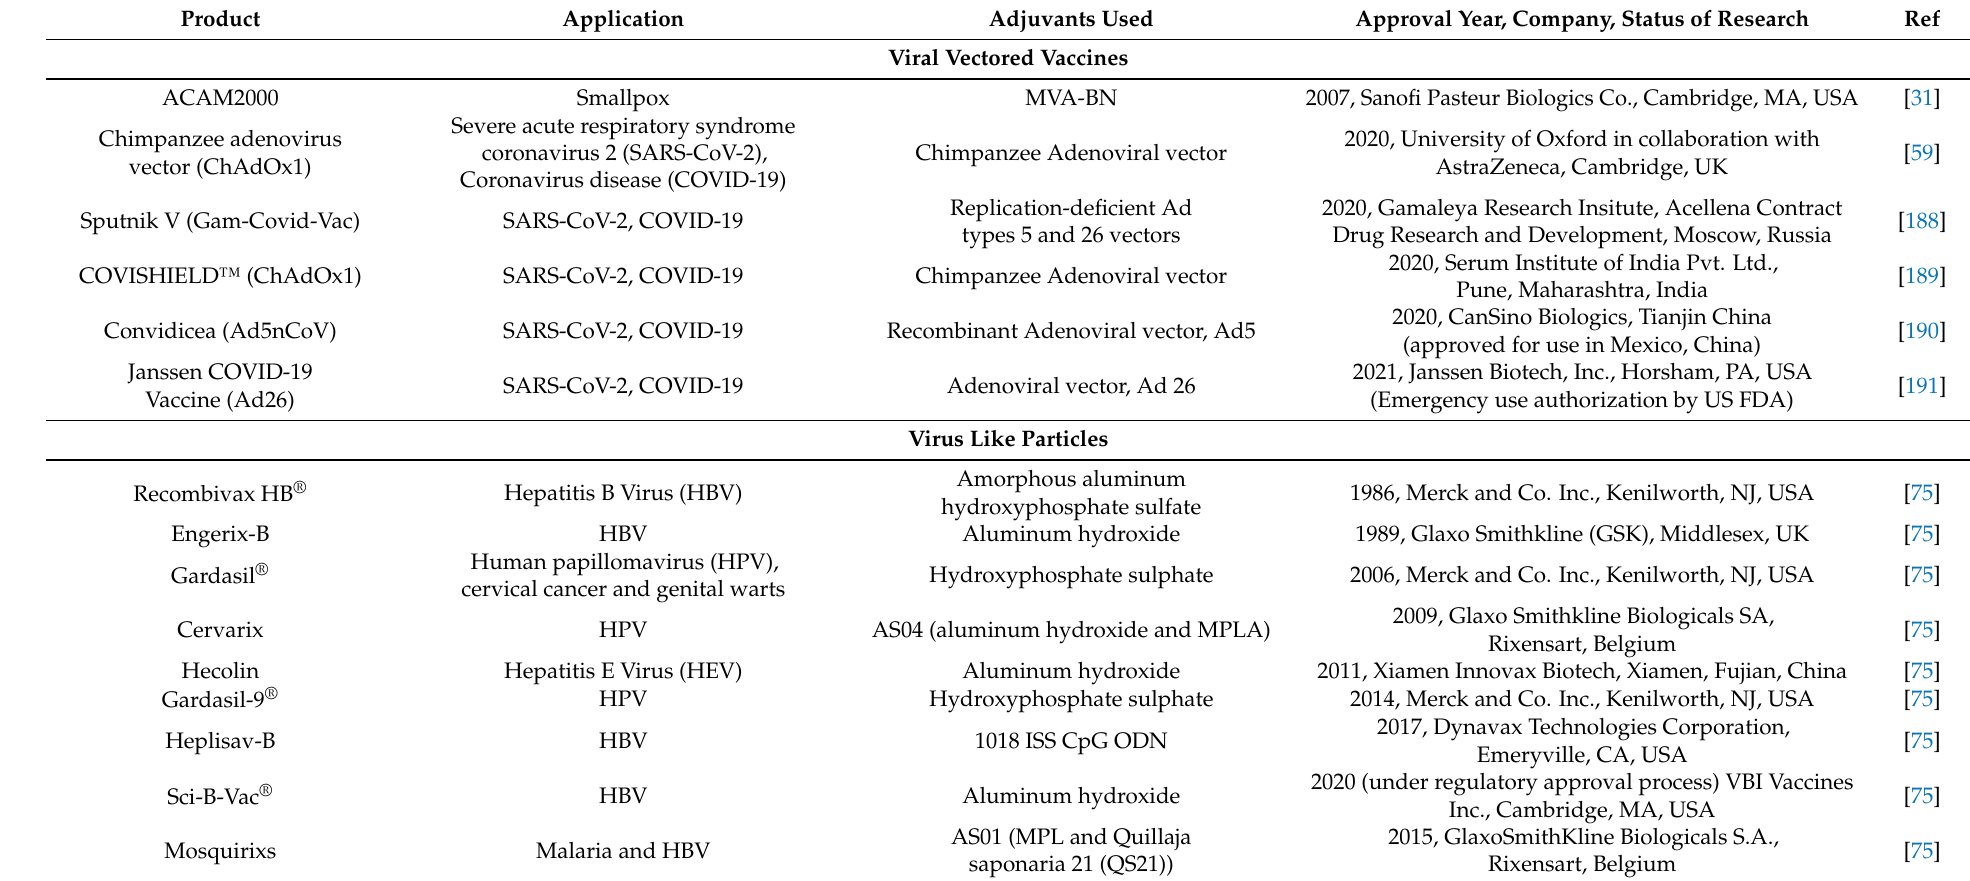
Table 2. Approved and clinically tested vaccines using nanocarrier-based adjuvants and delivery